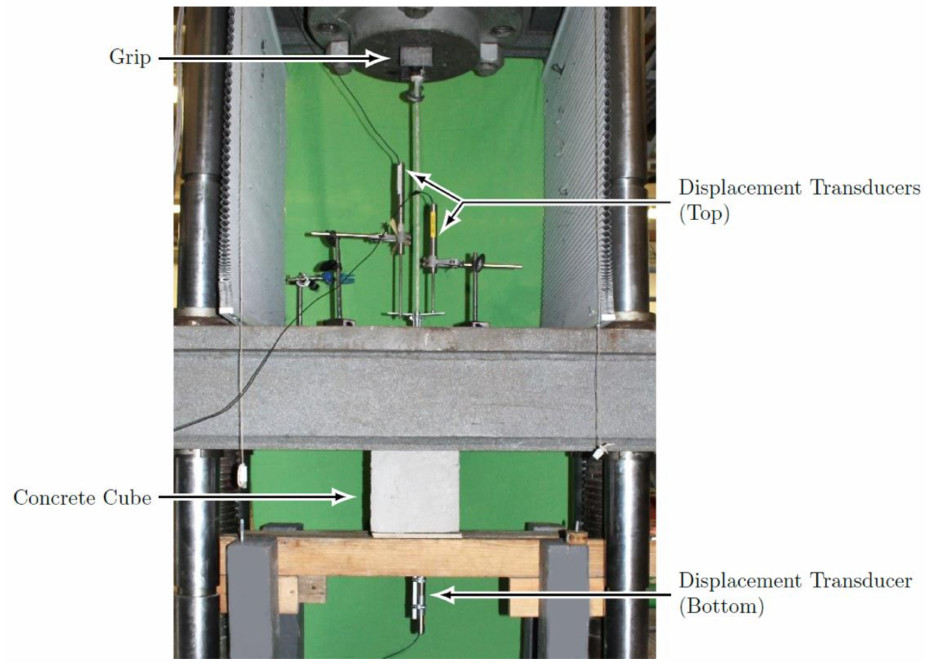
Figure 3. ‘Pull-out’ test